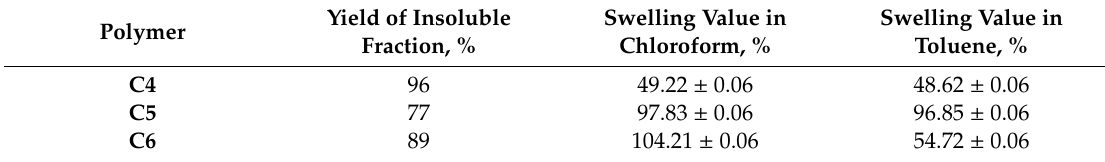
Table 3. Characteristics of the cross-linked vanillin-based